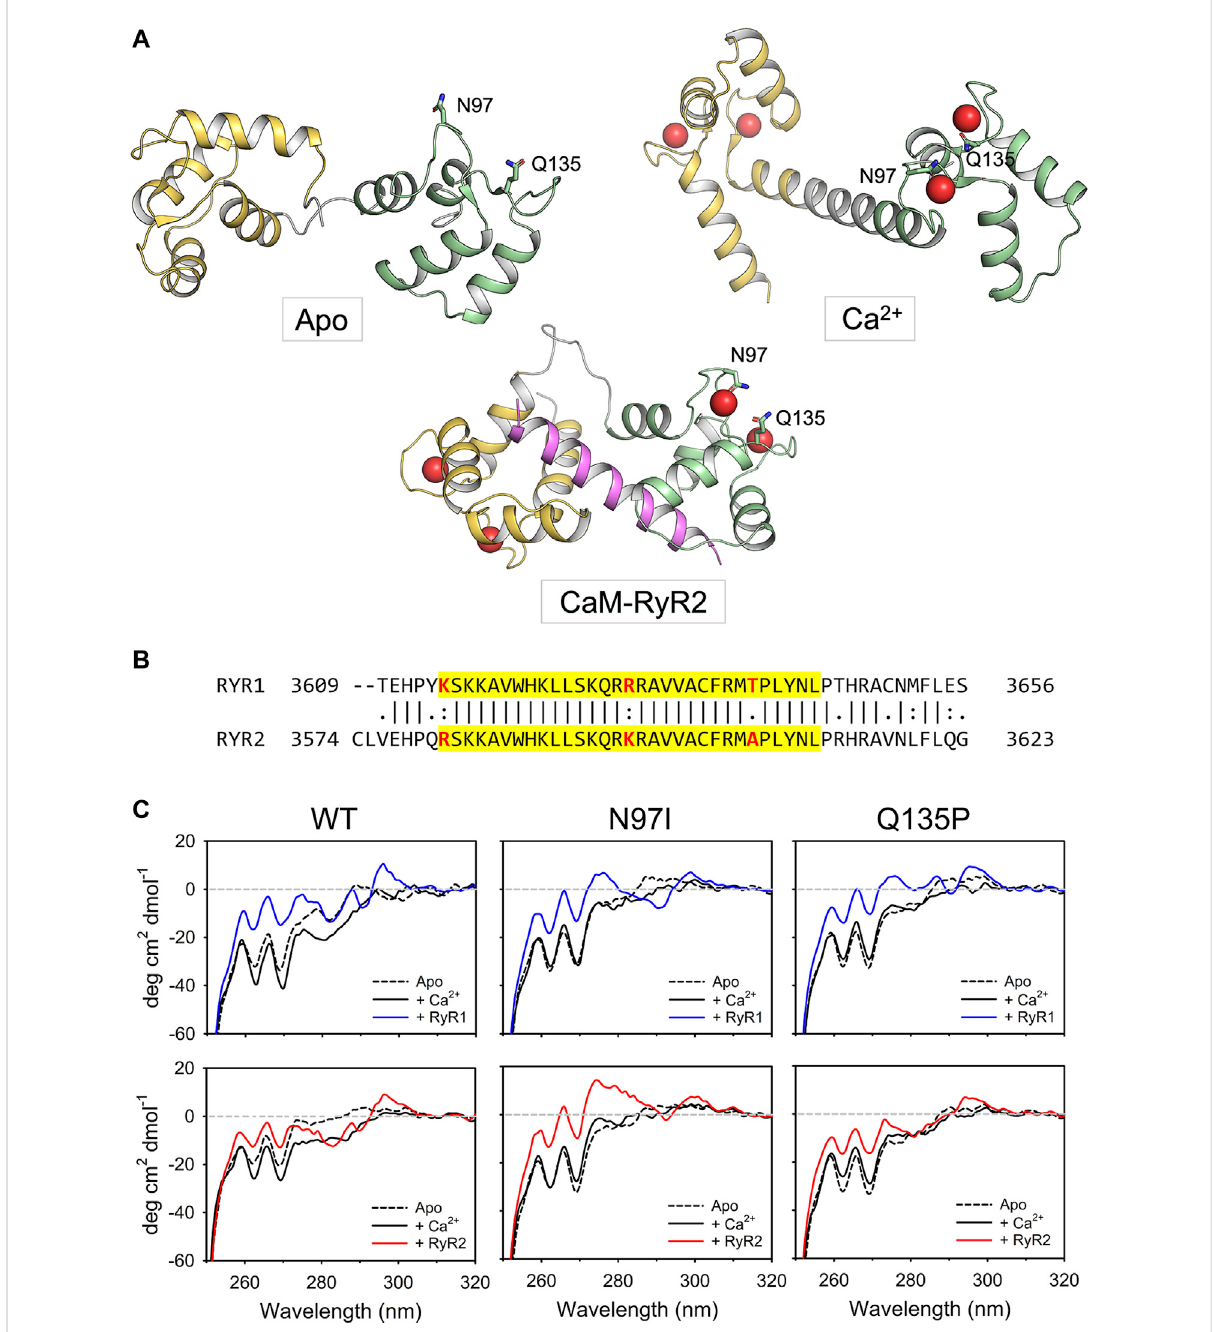
FIGURE 1 Tertiary and quaternary structure of CaM variants in complex with RyR1/2 peptides. (A) Cartoon representation of CaM in three different conformational states, namely apo (PDB: 1DMO (Zhang etal., 1995)), Ca 2+ -bound(PDB: 1CLL (Chattopadhyaya etal., 1992))and complexedwith the RyR2 peptide used in this study (PDB: 6Y4O (Holt et al., 2020)). The N-terminal domain is colored in yellow, the linker region in grey, while the C-terminal domainingreen.TheRyR2peptideisrepresentedinmagenta.Ca 2+ ionsarerepresentedasredsphereswhilethesidechainsofN97 and Q135 are represented in sticks with C atoms colored according to the structural region, O atoms in red and N atoms in blue. (B) Pairwise sequence alignment of the Calmodulin Binding Domain-2 of human RyR1 (Uniprot entry P21817) and RyR2 (Uniprot entry Q92736). The sequence relative to the two RyR peptides employed in this study is highlighted in yellow, the residues that are not identical in such region are represented in bold and colored in red. (C) Near-UV CD spectra (250 – 320 nm) of 50 μ M CaM were collected in the presence of 500 µM EGTA (black dashed line) and after sequential additions of 1 mM Ca 2+ (black solid line, 500 µM free Ca 2+ ) and 100 μ M RyR peptides (blue solid line for RyR1, red solid line for RyR2). The spectrum of sole buffer was considered as blank and subtracted; each curve represents the average of fi ve accumulations. Temperature was set at 25 ° C and signal was normalized to protein